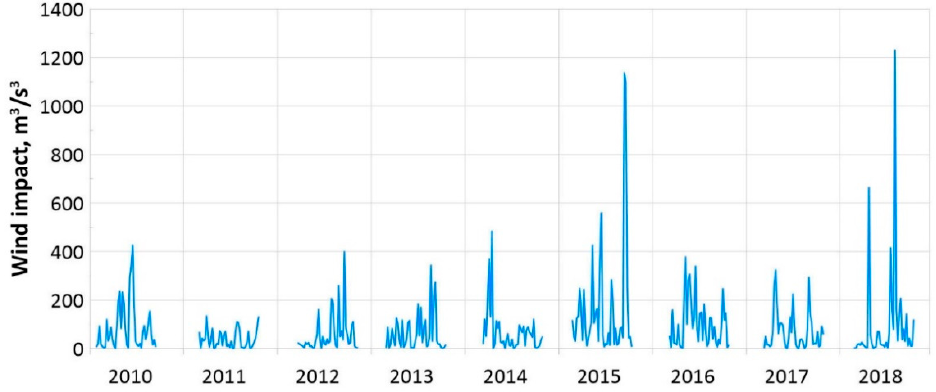
Figure 14. The average wind impact on the considered area from 1 May to 11 June 2010–2018.